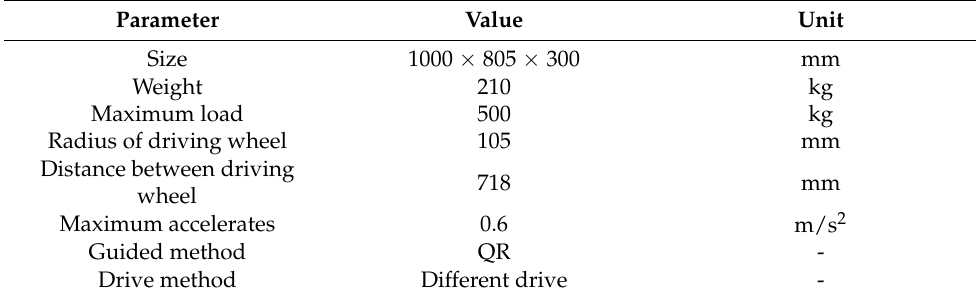
Table 3. Parameters of AGV.